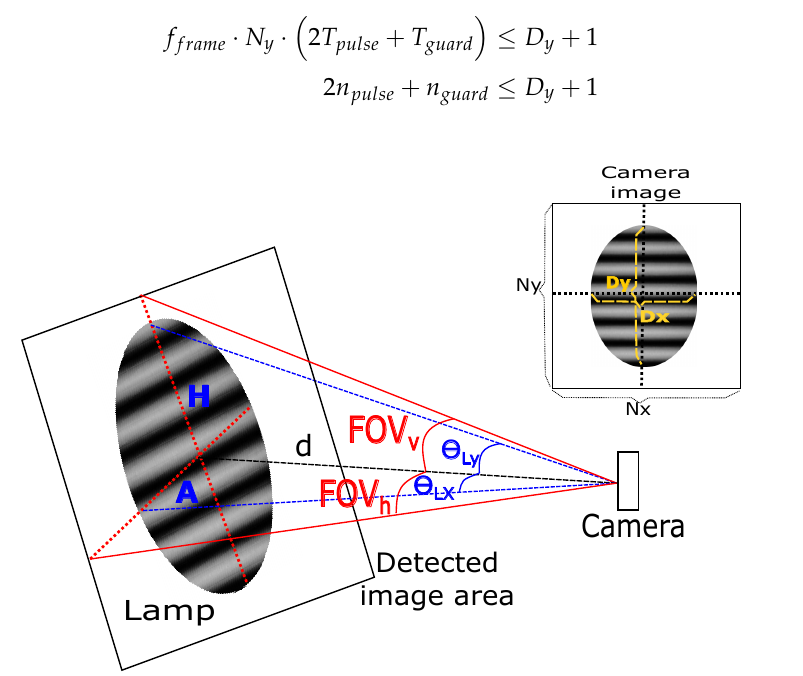
Figure 6. Geometrical scheme for spot size